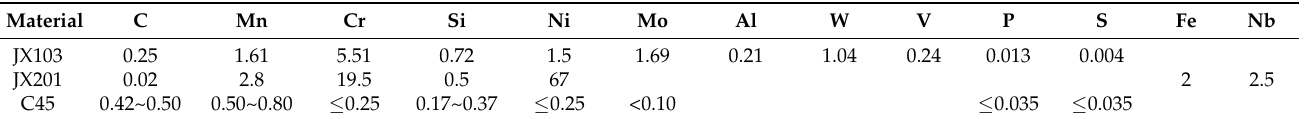
Table 1. Chemical composition of the materials